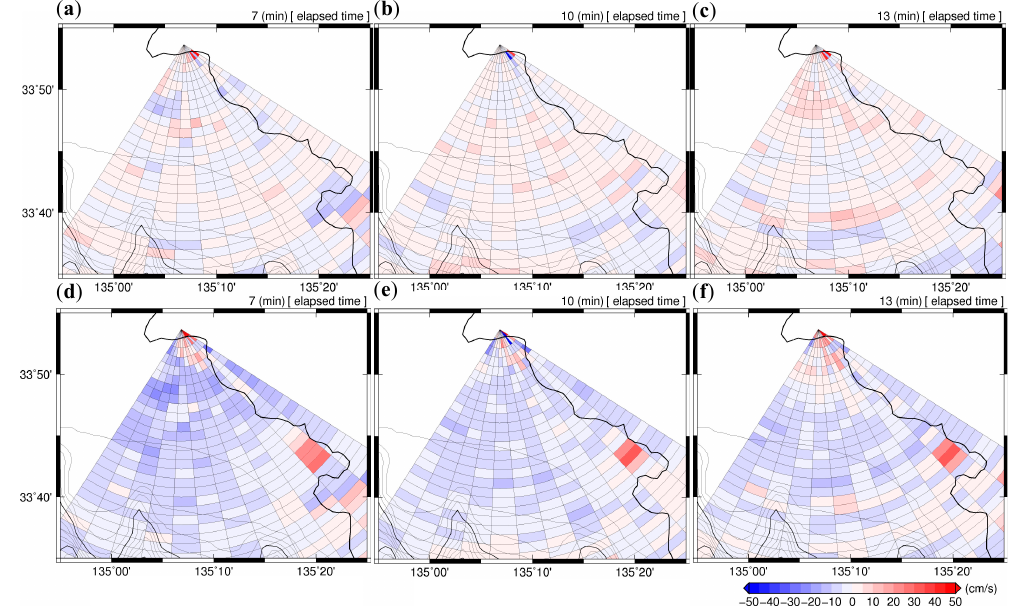
Figure 4. Spatial distributions of the differences between the simulated radial velocity and the extracted radial tsunami velocities by the present method ( a – c ) and by Fuji and Hinata (FH) method ( d – f ) for the 02010600 scenario. The background color represents the velocity difference between the two kinds of velocities.